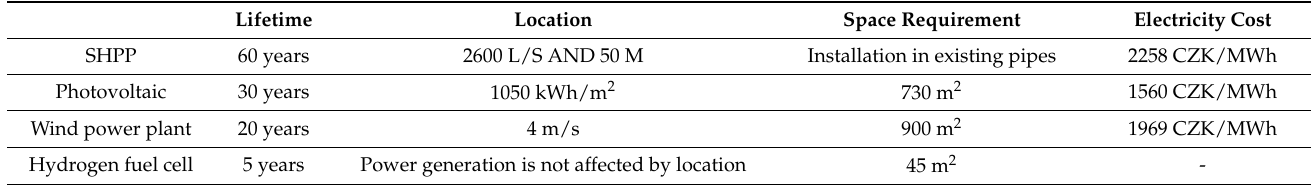
Table 3. Criteria data of the renewable power